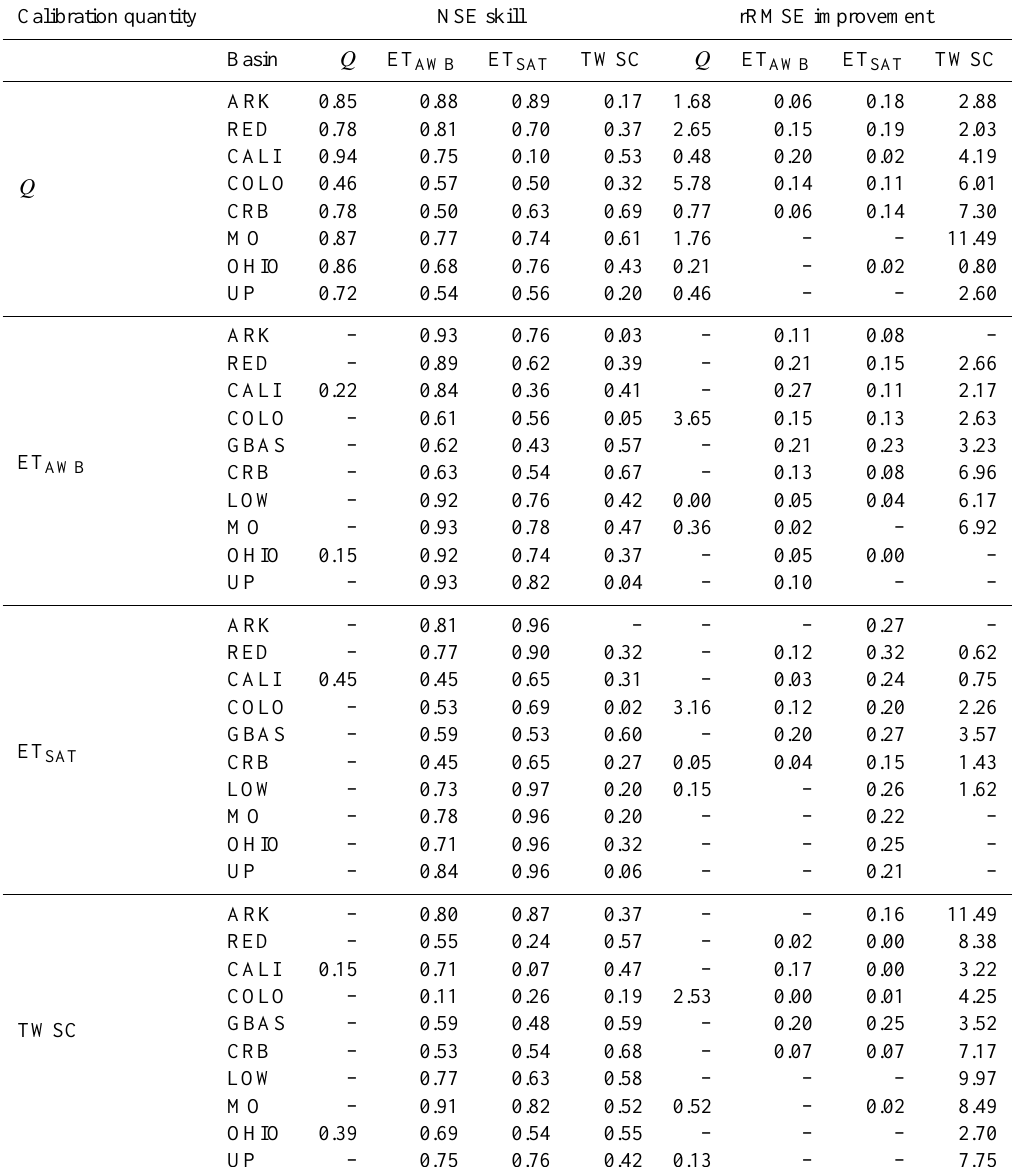
Table 3. Summary of skill scores and improvements with respect to model a priori performance, from the single-criterion calibrations; numeric values show improvement, while dash cells indicate no improvement in model skill for the respective variable. Underlined values denote the specific ET observation to which calibration was